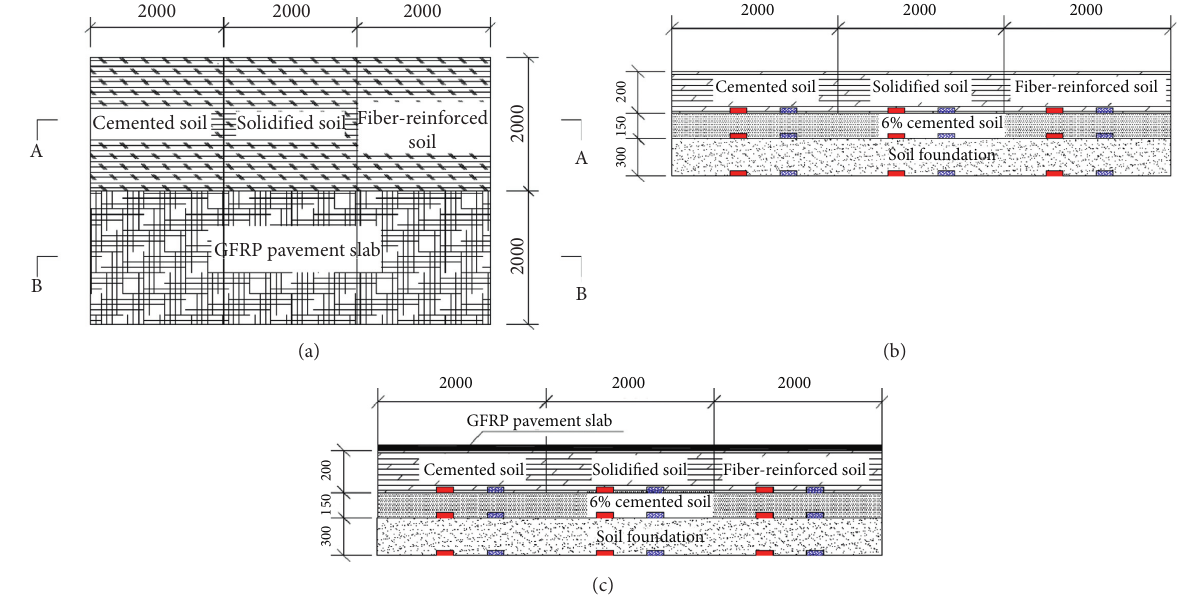
Figure 5: Size chart of the full-scale test section. (a) Ichnography. (b) A-A profile. (c) B-B profile.